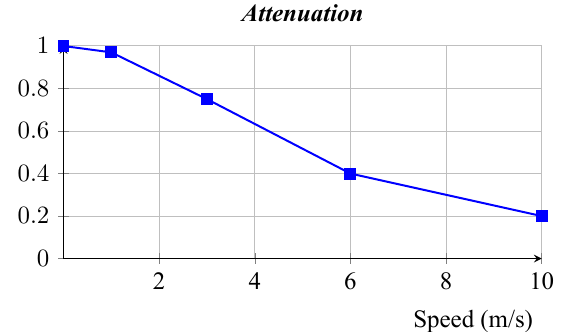
Figure 4. Handlebar attenuation curve as a function of bicycle speed, em- pirically obtained.